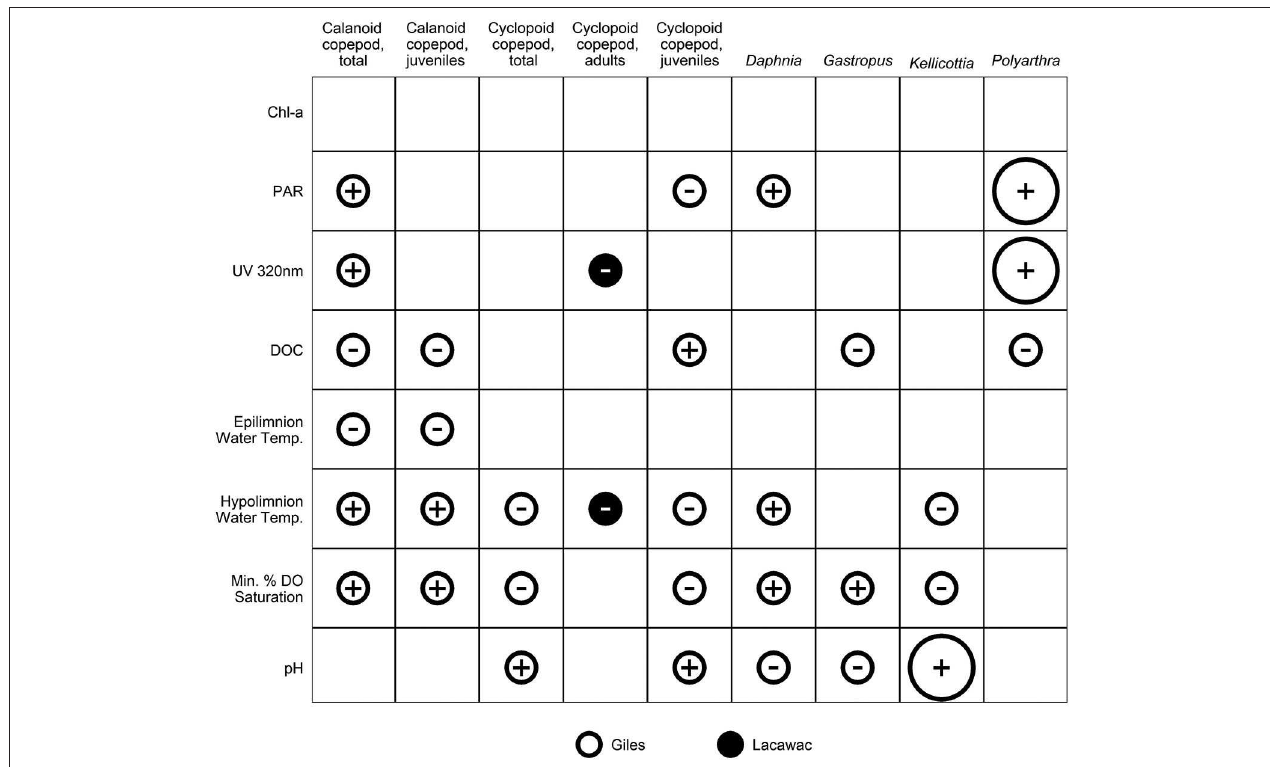
FIGURE 7 | Relationships between IAV and LTT of driver variables vs. zooplankton response variables. Rows are potential driver variables related to the resource-based or habitat-based hypotheses. Columns are zooplankton abundance response variables that had a significant long-term trend in either Giles or Lacawac. Small circles indicate when both the respective driver variable and zooplankton response variable LTT were statistically significant (Mann-Kendall non-parametric trend test, p < 0.05), and the direction of the interannual Spearman correlation was consistent with that of the LTT for the same lake (open white circles = Giles, filled black circles = Lacawac). Large points follow the same pattern, but indicate when the interannual Spearman correlation was consistent with that of the LTT, and also statistically significant (Spearman rank correlation, p < 0.05), suggesting a higher degree of confidence in predicting LTT from IAV data. Signs indicate the positive ( + ) or negative (–) nature of the relationship between the driver and response